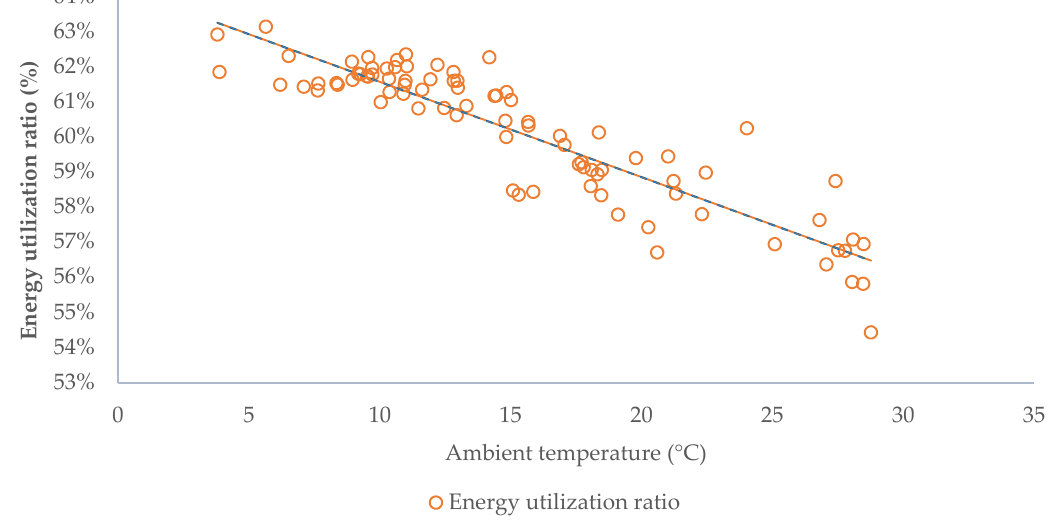
Figure 15. Correlation of energy utilization ratio with the annual average ambient temperature.